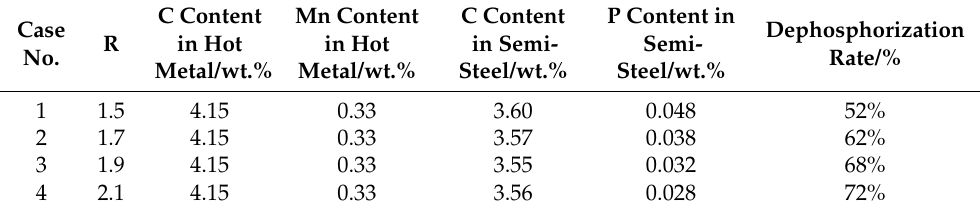
Table 1. The effect of slag basicity on the dephosphorization